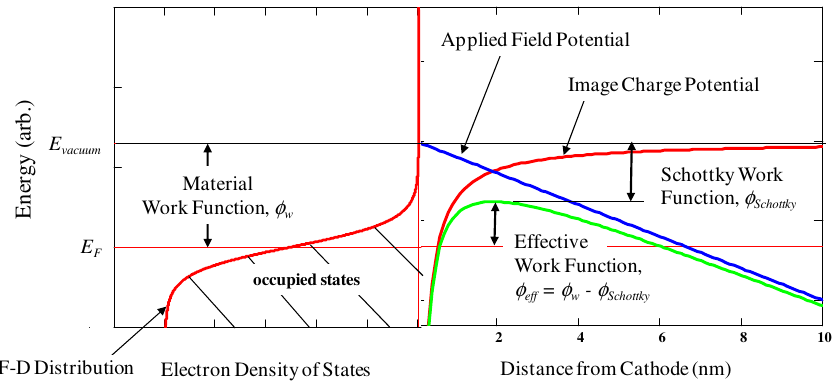
FIG. 2. (Color) The energy distribution of occupied states for a metal (left) and the electric potentials next to the cathode surface (right). The Schottky potential (green curve) is the sum of the applied field potential (blue) and the image charge potential (red). The Schottky work function is the amount the material work function is reduced at the peak of the Schottky potential. The Schottky potential is shown for an applied field of 100 MV = m where the peak of the photoemission barrier is 1.9 nm from the surface. The effective work function is the height of this barrier above the Fermi level and is the material work function reduced by the Schottky work